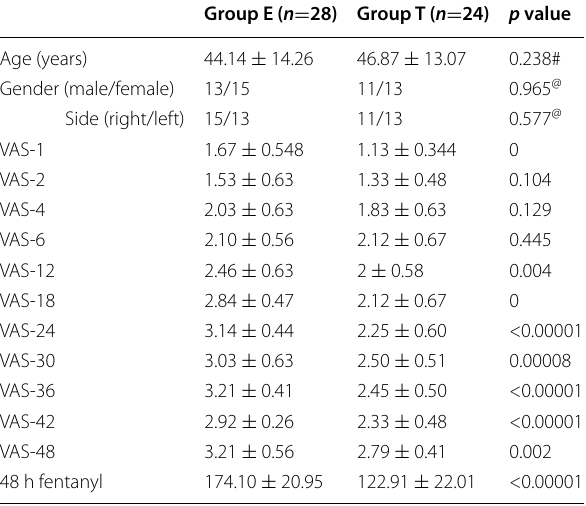
Table 1 showing demographic differences, comparison of pain scores, and 24-h opioid consumption between group T and group E